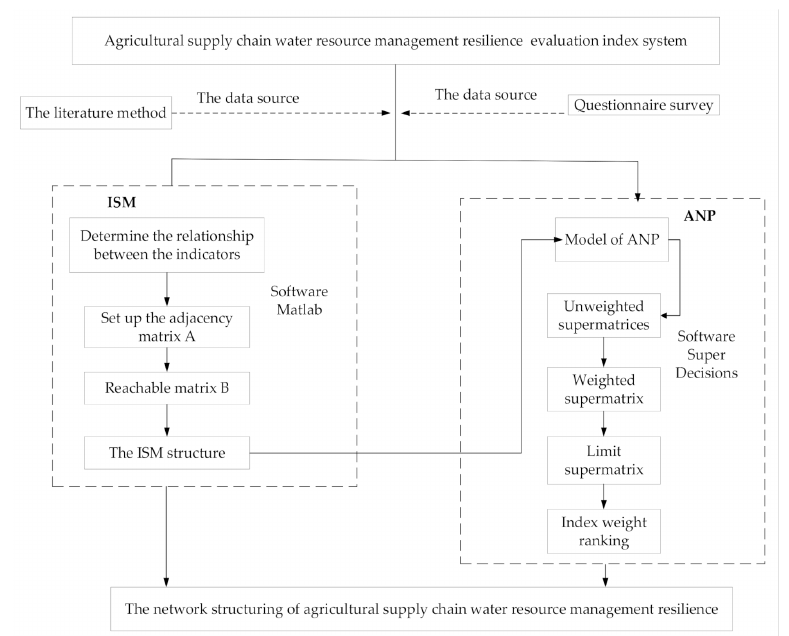
Figure 1. Factor analysis of agricultural supply chain water resource management resilience based on